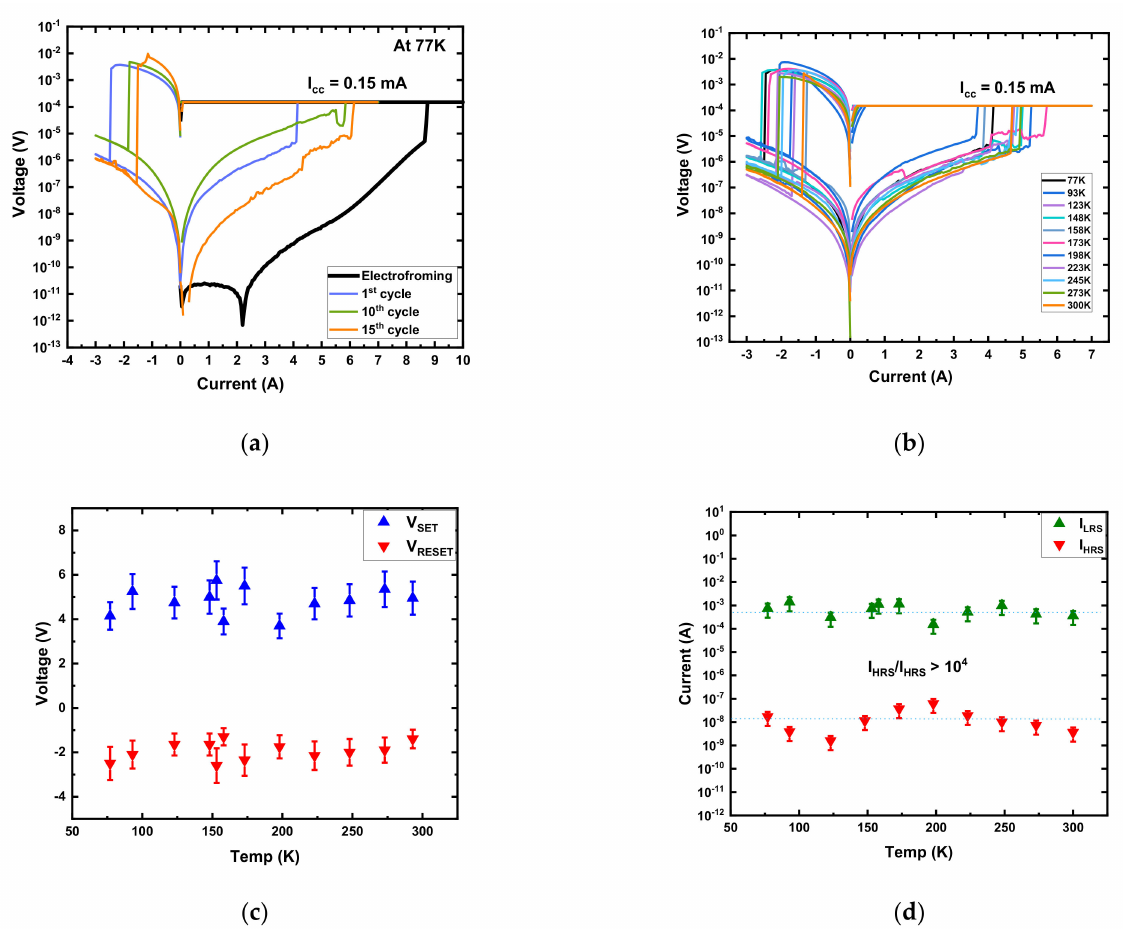
Figure 3. Au/Ni/SiO x N y /p + -Si memory device performance in a vacuum. ( a ) Typical I–V curves at 77 K; ( b ) typical I–V curves with temperature variation from 77 K to 300 K; ( c ) V SET and V RESET vs. temperature; ( d ) I LRS and I HRS vs.